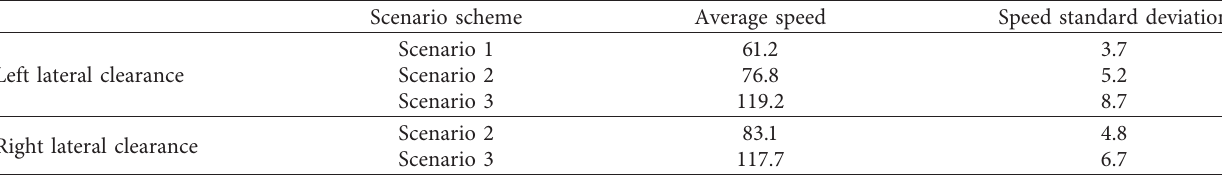
Table 6: Descriptive statistics of speed indicators for different design speed schemes.